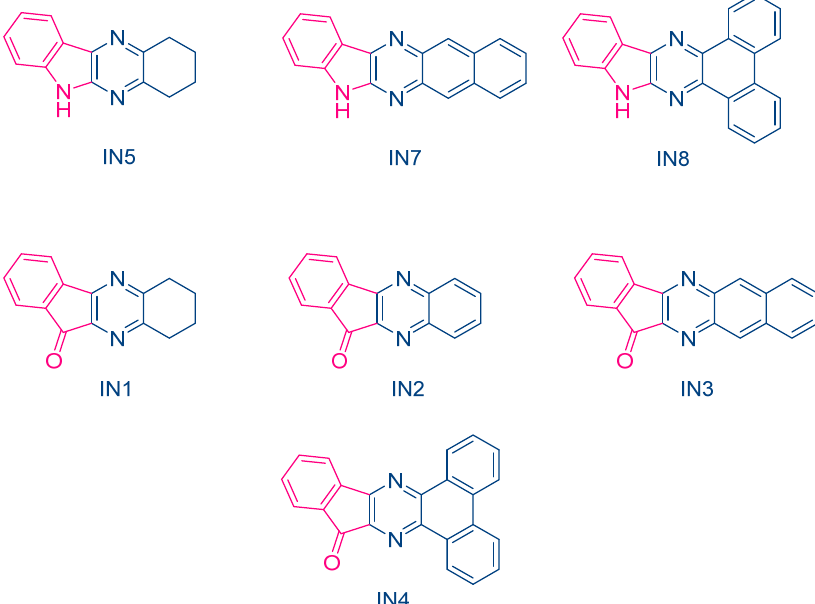
Figure 10. Chemical structures of indenono- and indoloquinoxaline derivatives.